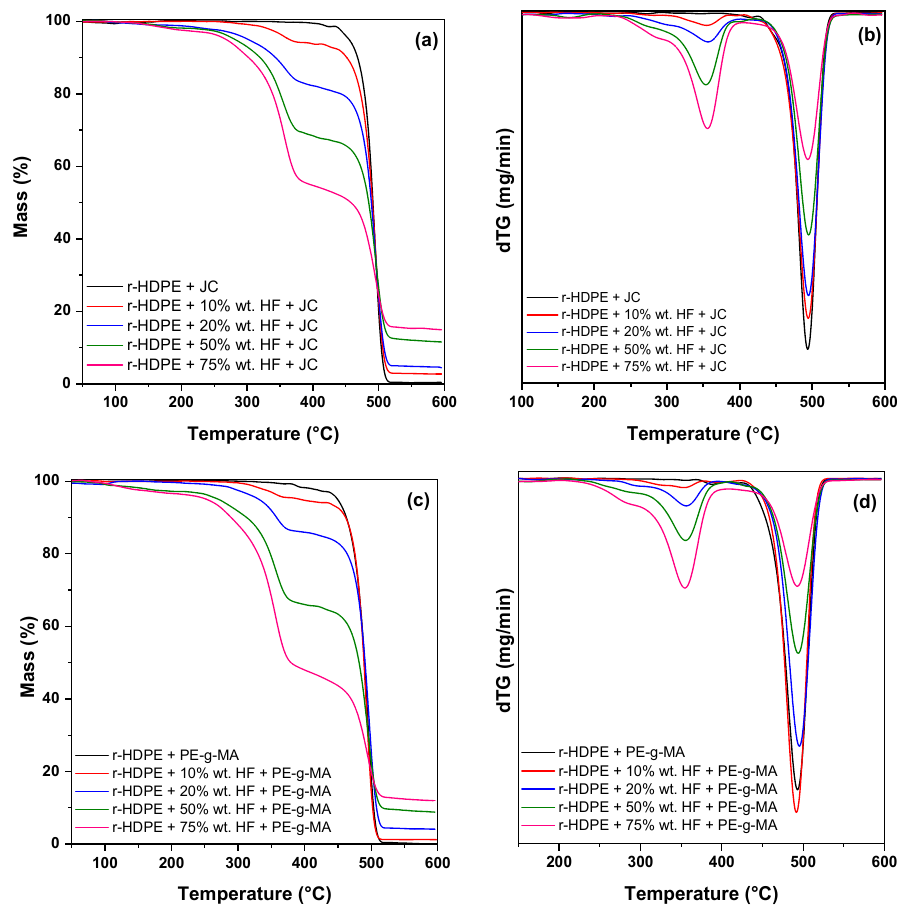
Figure 7. Comparative thermograms of the mass loss and the derivative of the mass loss of ( a , b ) recycled high-density polyethylene (r-HDPE) + hemp fibers (HF) + Joncryl (JC) and ( c , d ) r-HDPE + HF + polyethylene-grafted maleic anhydride (PE-g-MA) composite materials.